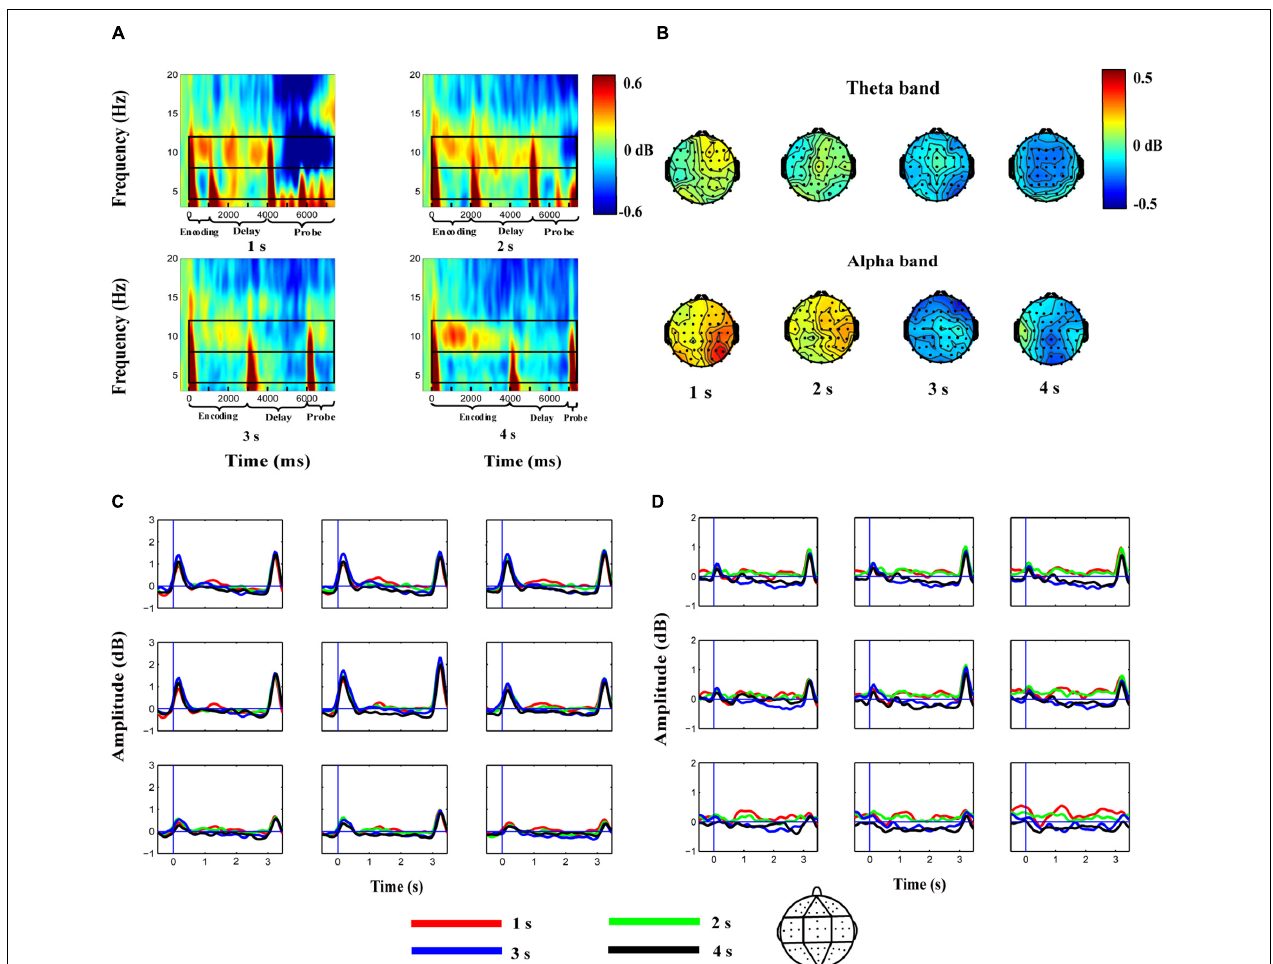
FIGURE 2 | Average EEG spectrum power for the whole epoch (A) , topographies of theta and alpha activity in the delay phase (B) , and average theta (C) and alpha (D) band powers during the maintenance of the auditory duration in WM in the 1, 2, 3, and 4-s duration conditions. (A) Decibel-transformed was relative to the baseline interval ( − 0.4 to − 0.1 s) before the sample stimulus. Theta oscillations are enhanced at the onset and offset of stimuli, whereas alpha oscillations are enhanced during the encoding, especially the delay phase. (B) Topographies of theta and alpha activity in the 1, 2, 3, and 4-s conditions during auditory duration maintenance in WM. Alpha band powers mainly activated in the posterior from the interval of 1–3 s after the onset of delay. (C,D) Steady theta (4–8 Hz) and alpha (8–12 Hz) band activities are elicited during WM maintenance after averaging across frequency and are separately plotted for each of the nine analyzed electrode clusters. Zero of the x-axis represents the onset of the delay phase. Red, green, blue, and black curves denote the 1, 2, 3, and 4-s auditory duration conditions